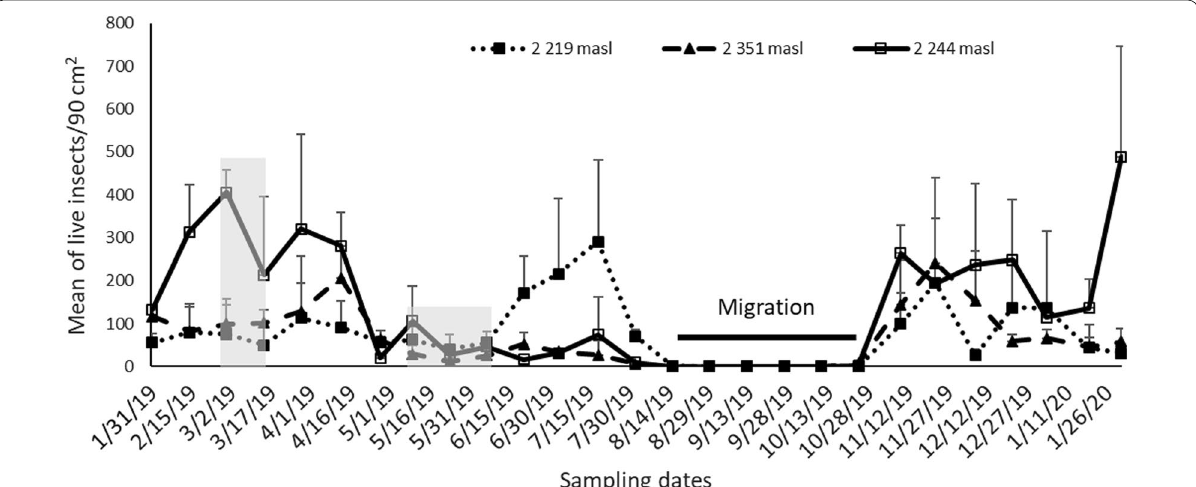
Fig. 1 Seasonality of populations of Oebalus mexicana in hibernation sites of the Zináparo hill, Michoacán, México. 2019–2020. The lines over the points indicate the standard deviation ( n 3). Gray bar indicates swarm periods =